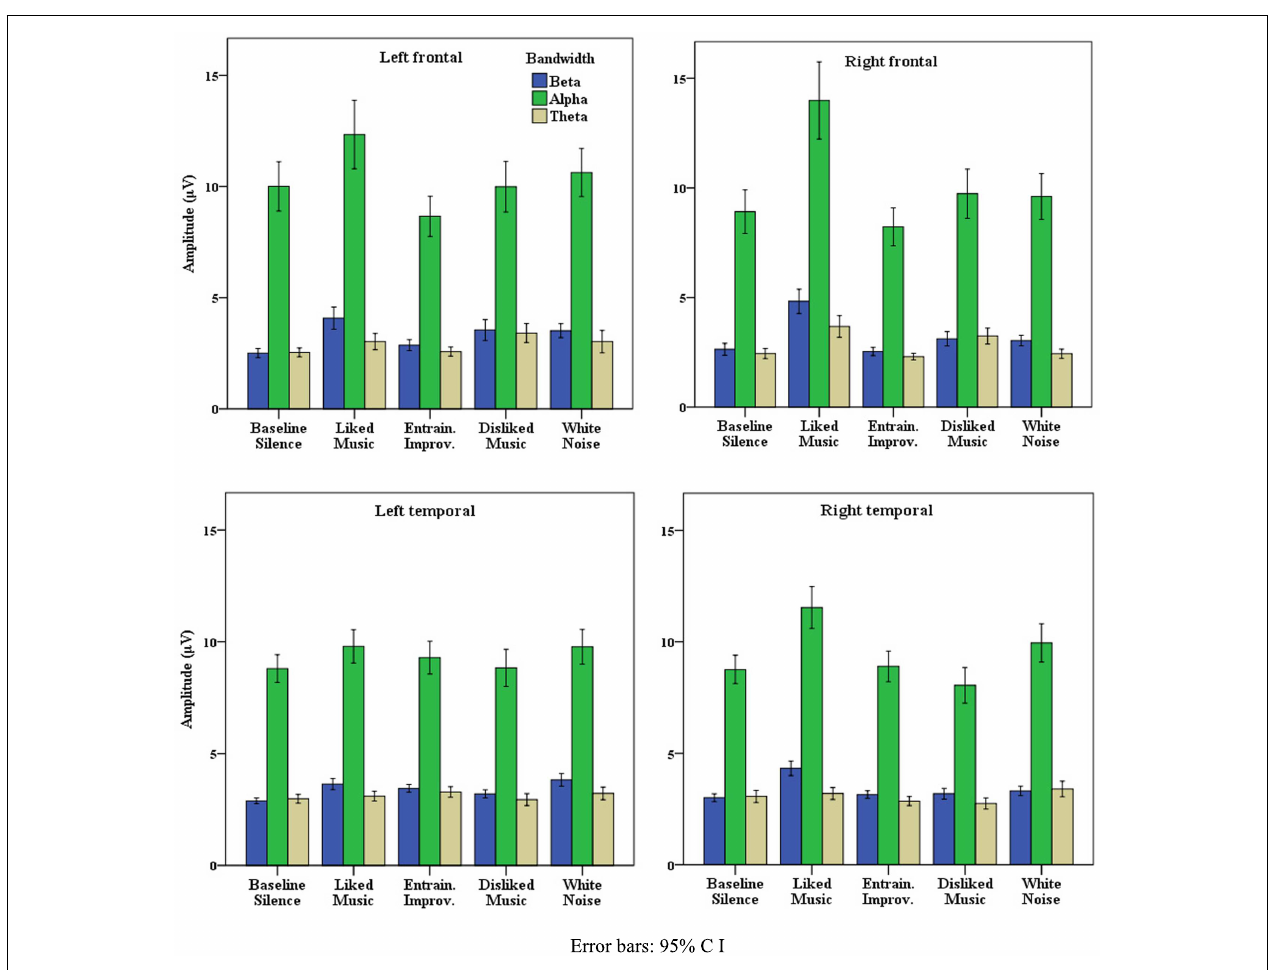
FIGURE 1 | Healthy frontal and temporal EEG activity